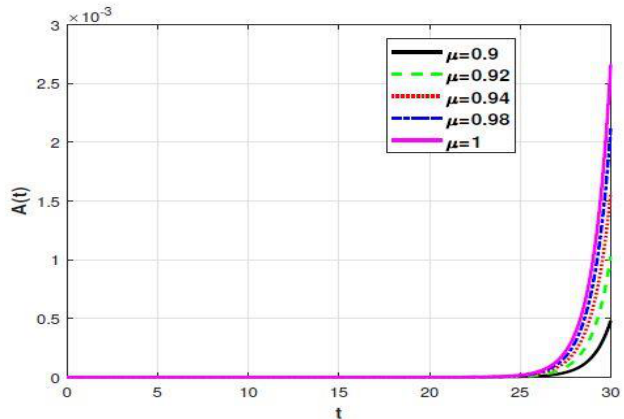
Fig. 4. Numerical experiments of healed class for various value of fractional order 𝛍.